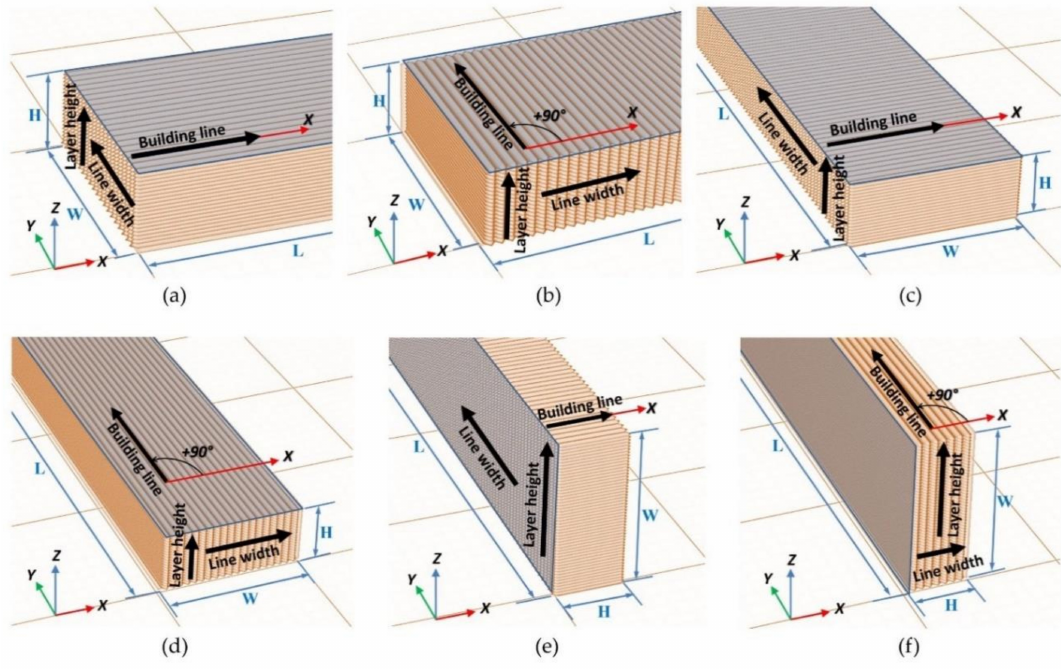
Figure 3. Internal sample geometry code: ( a ) XY + 0; ( b ) XY + 90; ( c ) YX + 0; ( d ) YX + 90; ( e ) YZ + 0; ( f ) YZ + 90. For each internal geometry, the directions of each dimension of the building lines (Figure 2) can be related to directions of the outer dimensions of the sample: length (L), width (W) and height (H) (Table